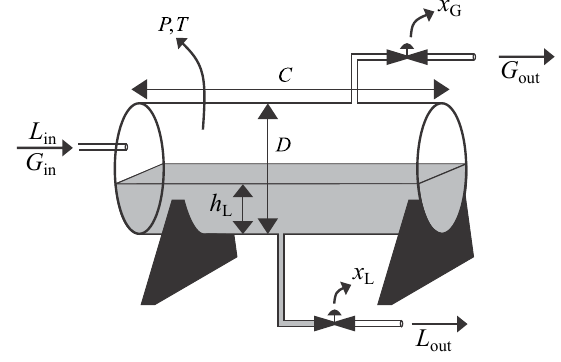
Figure 2. Biphasic gravitational